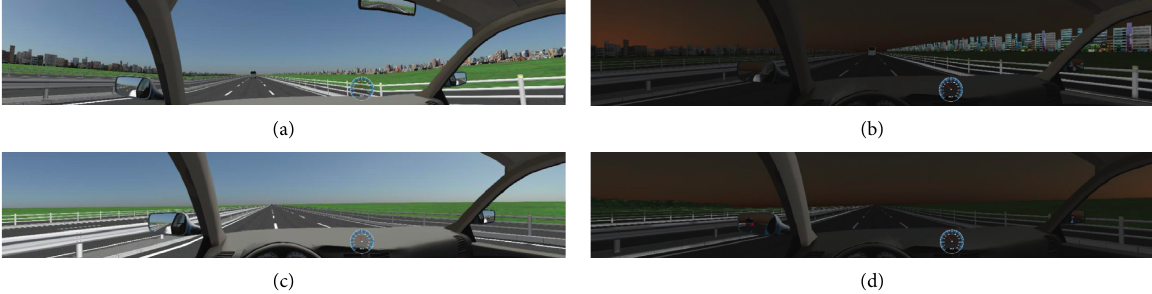
Figure 2: Experiment scenarios. (a) Front identification in daylight. (b) Front identification in twilight. (c) Rear identification in daylight. (d) Rear identification in twilight.